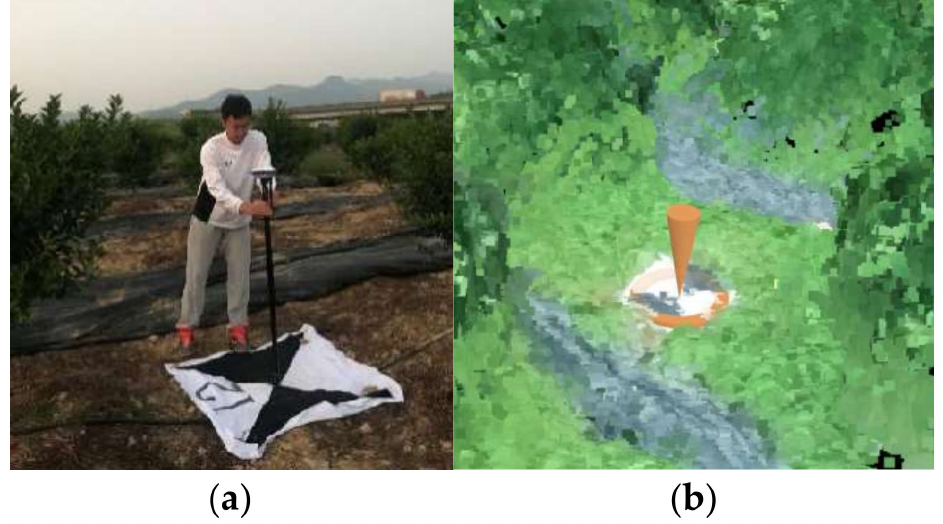
Figure 11. Field sampling and point cloud sampling: ( a ) on-site extraction of WGS 84 coordinates of sampling points; ( b ) point cloud model extraction